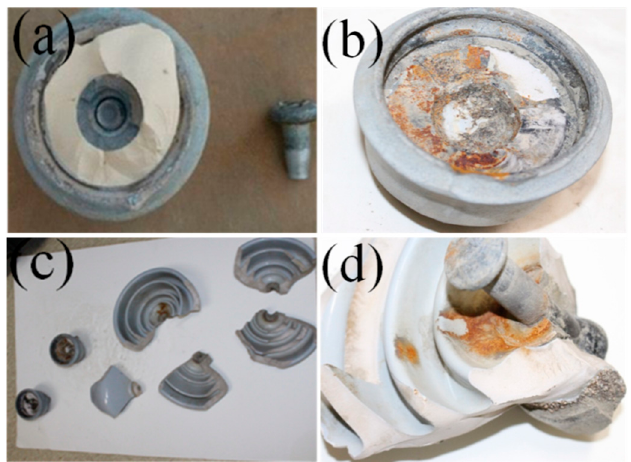
Figure3. ( a )Separationofpin, ( b )Separationofmetalcap, ( c )Shatteredporcelaininsulator, ( d )Fractured Figure 3. ( a ) Separation of pin, ( b ) Separation of metal cap, ( c ) Shattered porcelain insulator, ( d ) porcelain Fractured porcelain insulator.